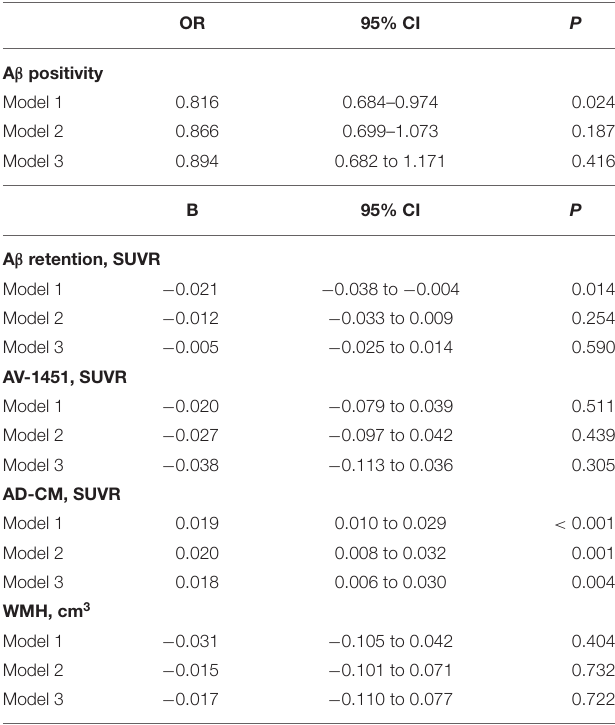
TABLE 2 | Results of multiple logistic and linear regression analyses for assessing the relationship between hemoglobin level and A β , AV-1451, AD-CM, or WMH in non-demented older